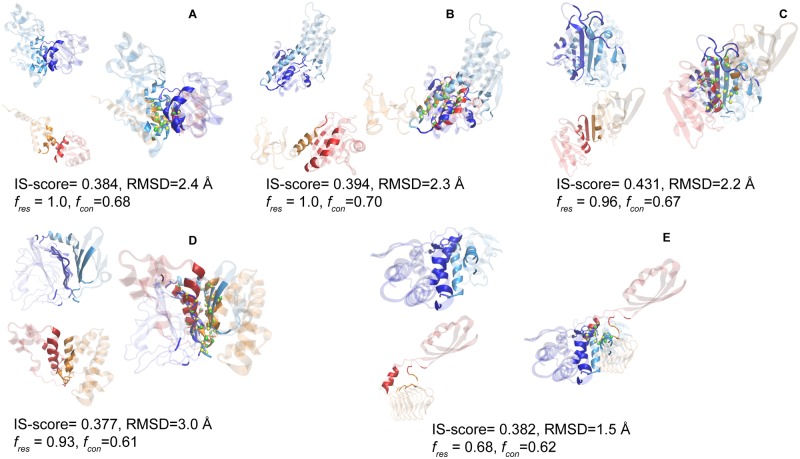
Examples of similar intra-chain domain-domain interface pairs.Two domains of template protein are shown in cyan and blue colors, while target protein domains are shown in orange and red colors. The aligned C-alpha residues are shown in green and yellow for target and template structures respectively. A) Periplasmic receptor CeuE (domains 1 and 2 of 4inoA) and manganese transport regulator (MNTR) protein (domains 1 and 2 of 2f5fB), PDB identifier is followed by the chain identifier. B) RhoA-dependent invasion protein (domains 1 and 2 of 4ldrB) and Peroxiredoxin protein (domains 1 and 2 of 2v2gA). C) Pullulanase enzyme (domains 3 and 4 of 2fh8A) and DNA polymerase sliding clamp (domains 1 and 2 of 4tr8B). D) Hyaluronate lyase enzyme (domains 1 and 3 of 1n7oA) and serum albumin (domains 5 and 6 of 4f5uA). E) Thermolysin (domains 1 and 2 of 4n4eE) and tetrahydropicolinate succinyltransferase (domains 1 and 2 of 3r8yB). The coordinates of structures were obtained from the PDB. In superposed structures, the interface and non-interface regions are shown in solid and transparent color respectively. Molecular images are generated using VMD [52].